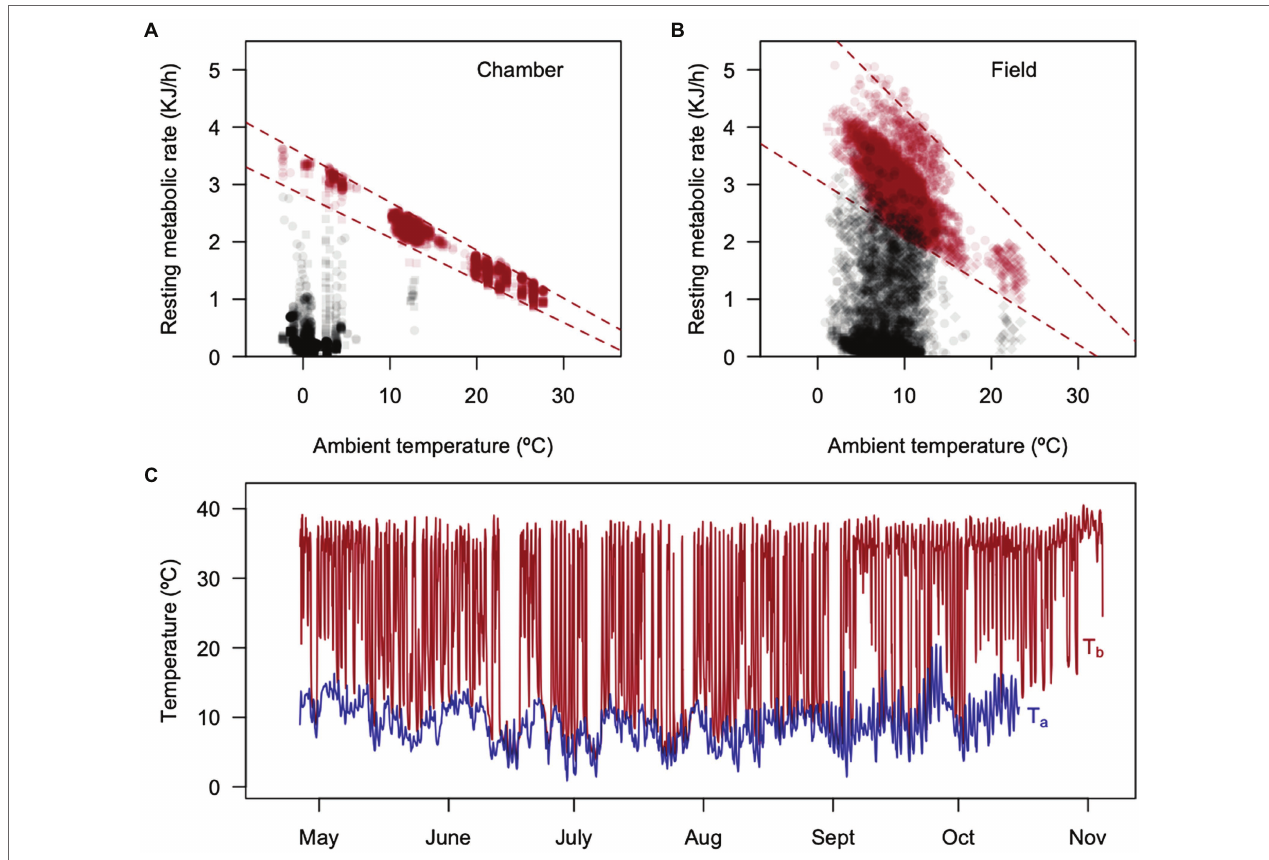
FIGURE 7 | Summaries of calculated RMRs from Figure 5 , using Newton’s equation for passive cooling: RMR = C min ( T B − T A ), where C min = 3.4848 Jg − 1 h − 1 ° C − 1 (Bozinovic et al., 2004), comparing the metabolic variability obtained in a climatic chamber (A) ramp experiments and in the field (B) outdoor experiments. (C) Shows the ambient and body temperature of a representative individual during the outdoor